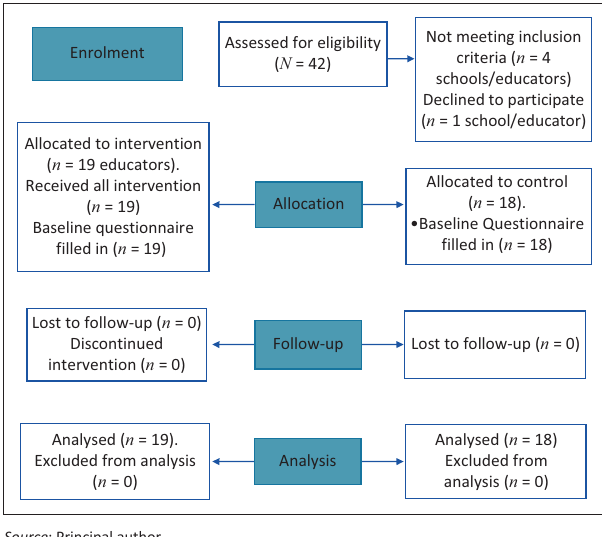
FIGURE 1: Flow diagram of visual acuity screening by Grade 5 educators in Chatsworth primary schools in 2013.